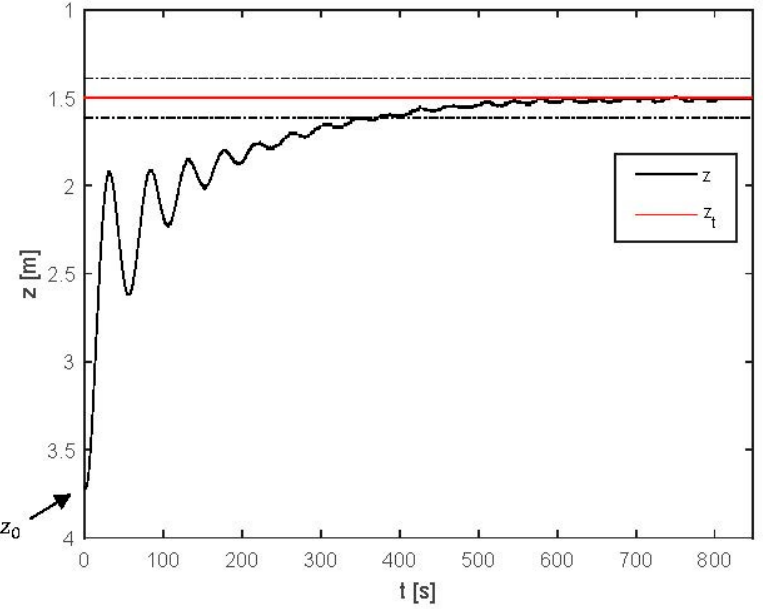
Figure 11. PI control, step response to evaluate steady state error: z is the BCD depth, z t is the target depth and the dashed dot lines represent a ±5% band around z t.